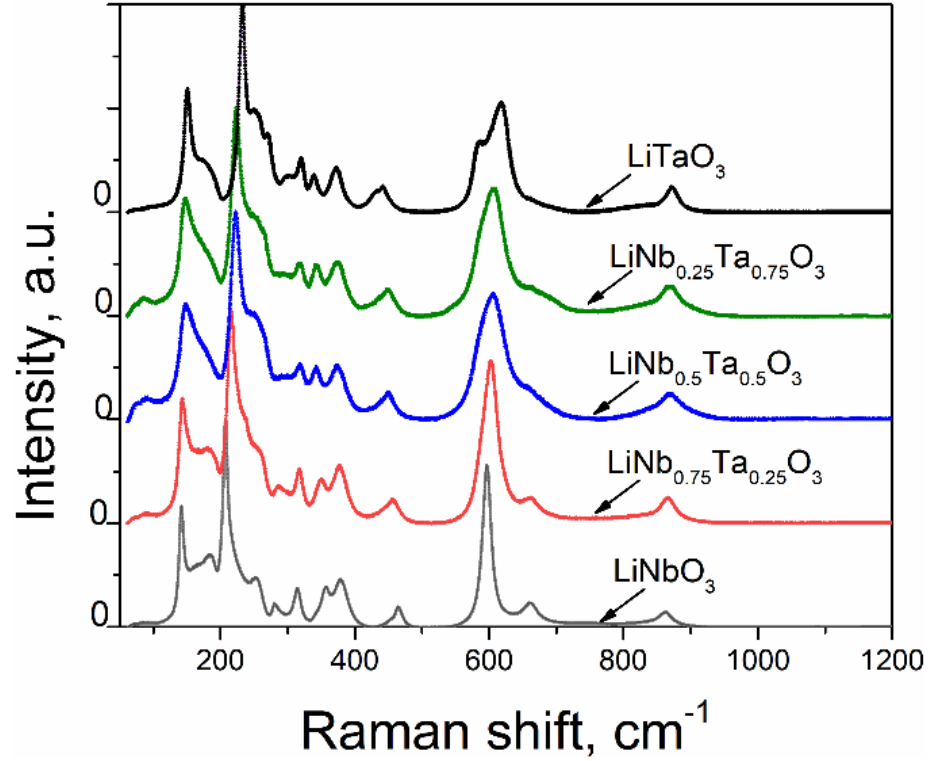
Figure 11. Raman spectra of LiNb